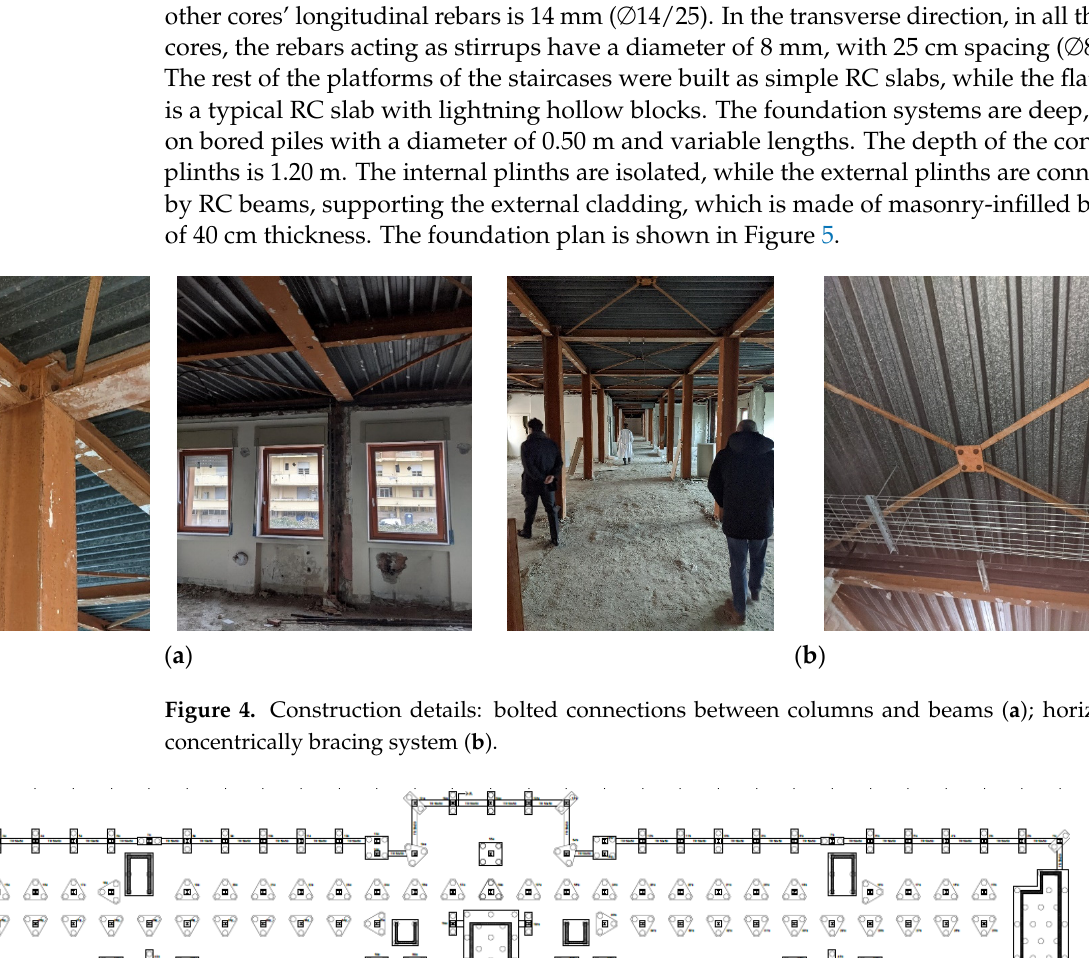
Figure 4. Construction details: bolted connections between columns and beams ( a ); horizontal concentrically bracing system ( b ).